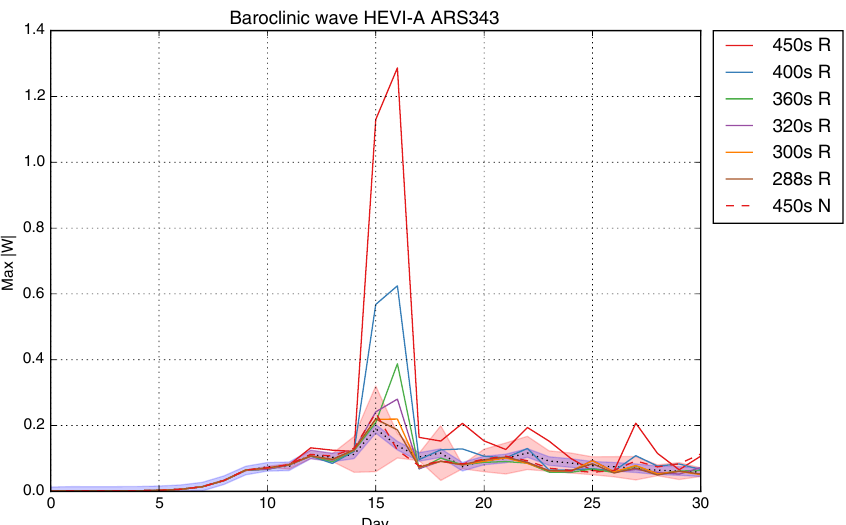
Figure 7. The maximum vertical velocity with ARS343 using the Rosenbrock-like approach (solid lines) and the Newton solver (dashed line) for various time step sizes. The light red region defines the 99% confidence interval from the explicit simulations with perturbed initial conditions, and the light purple region is 10% of the maximum deviation in the 99% confidence